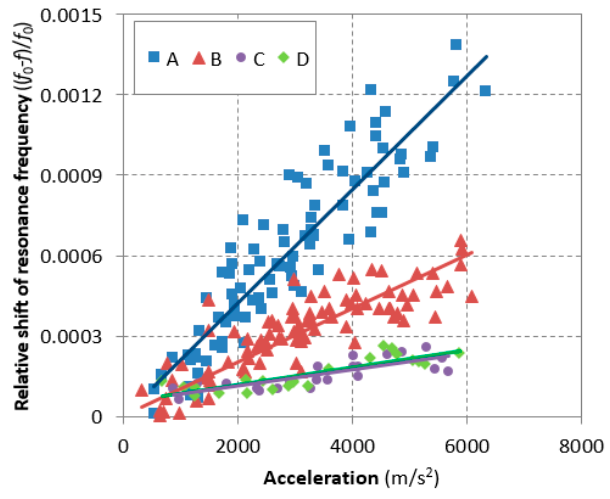
Figure 7. Total result of the relative resonance frequency of sample group A , group B , group C , and group D and the linear regression for calculating the hysteretic nonlinearity parameters.